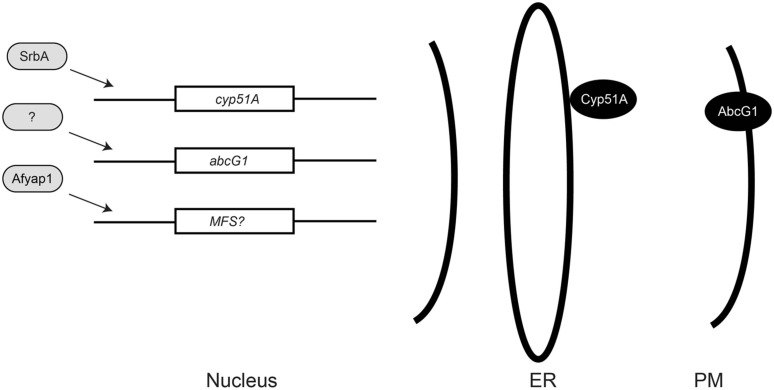
Relationships of azole resistance determinants in Aspergillus fumigatus. Known or putative transcription regulators are indicated in light gray as positive regulators of gene expression. The nuclear genes encoding the lanosterol α-14 demethylase (cyp51A), a plasma membrane (PM) ABC transporter (abcG1), or a major facilitator superfamily (MFS) transporter protein are indicated. Activation of an MFS-encoding gene by Afyap1 is still speculative at this point but is known to occur in other fungi (Alarco et al., 1997; Coleman et al., 1997; Rognon et al., 2006). The Cyp51A protein is docked to the endoplasmic reticulum (ER) by an N-terminal membrane spanning domain (Monk et al., 2014) while the AbcG1 protein is localized to the PM.